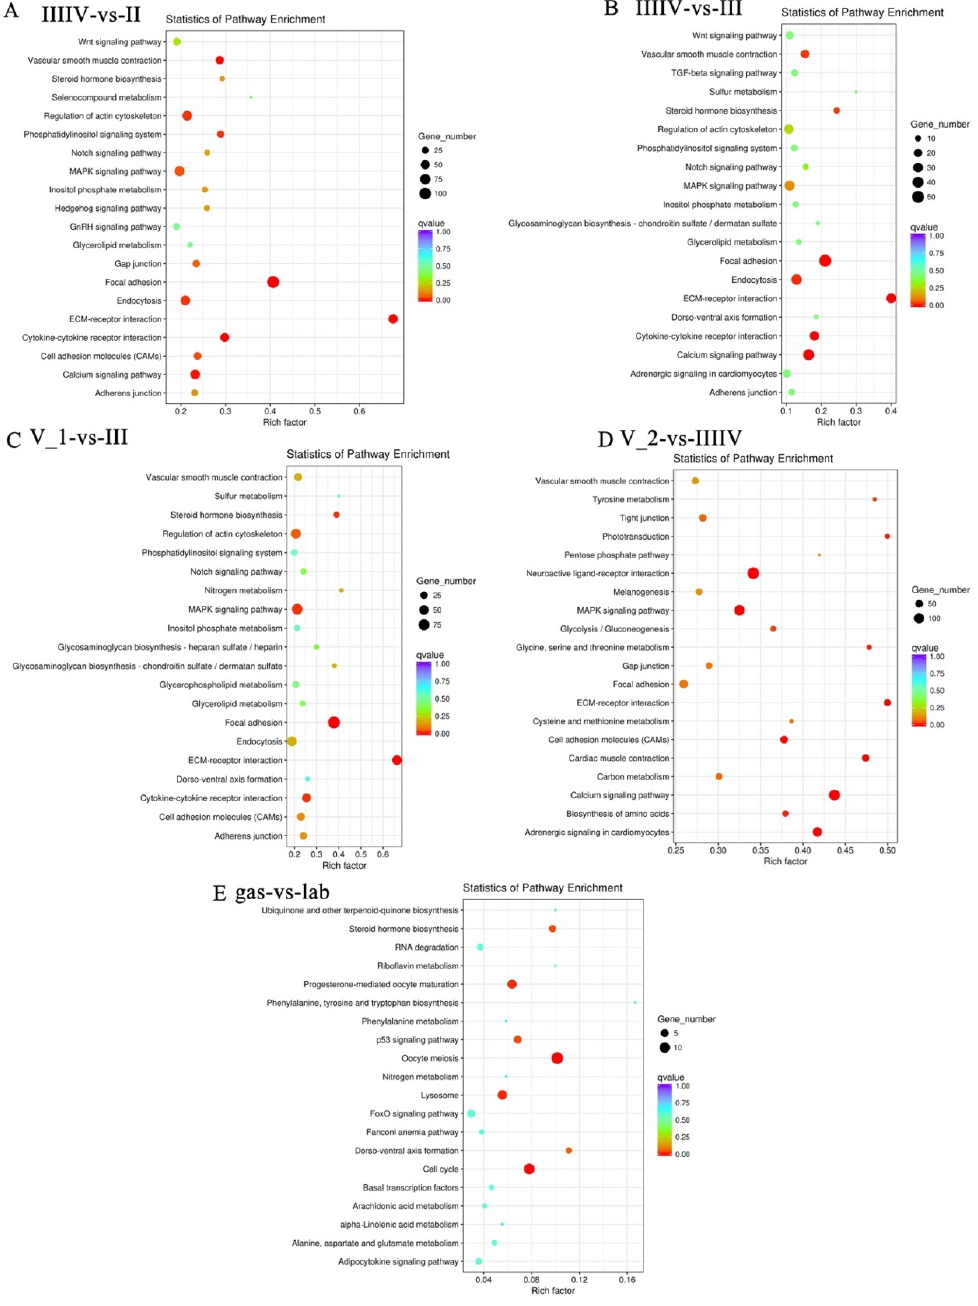
Figure 6. Scatter plots of enriched KEGG pathways for DEG(s) with a two-fold difference from the comparison of different stages. ( A ) IIIIV vs II, ( B ) IIIIV vs III, ( C ) V_1 vs III, ( D ) V_2 vs IIIIV, ( E ) gas vs lab. The rich factor is the ratio of the number of DEGs for a certain KEGG over the total genes in that pathway. Q value is the p value after correction for multiple testing. The color and size of the circles are q values and DEGs numbers,